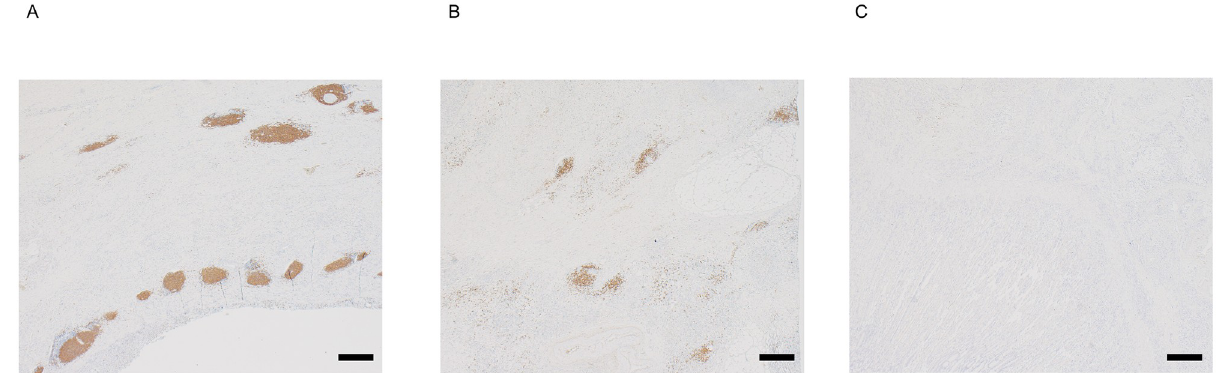
Fig 1. Representative immunohistochemical images of TLS. (A) Predominant staining pattern: the percent area of TLS was 2.9%. (B) Median range: the percent area of TLS was 1.24%. (C) Predominant nonstaining pattern: the percent area of TLS was 0%. Scale bars: 500 μ m.